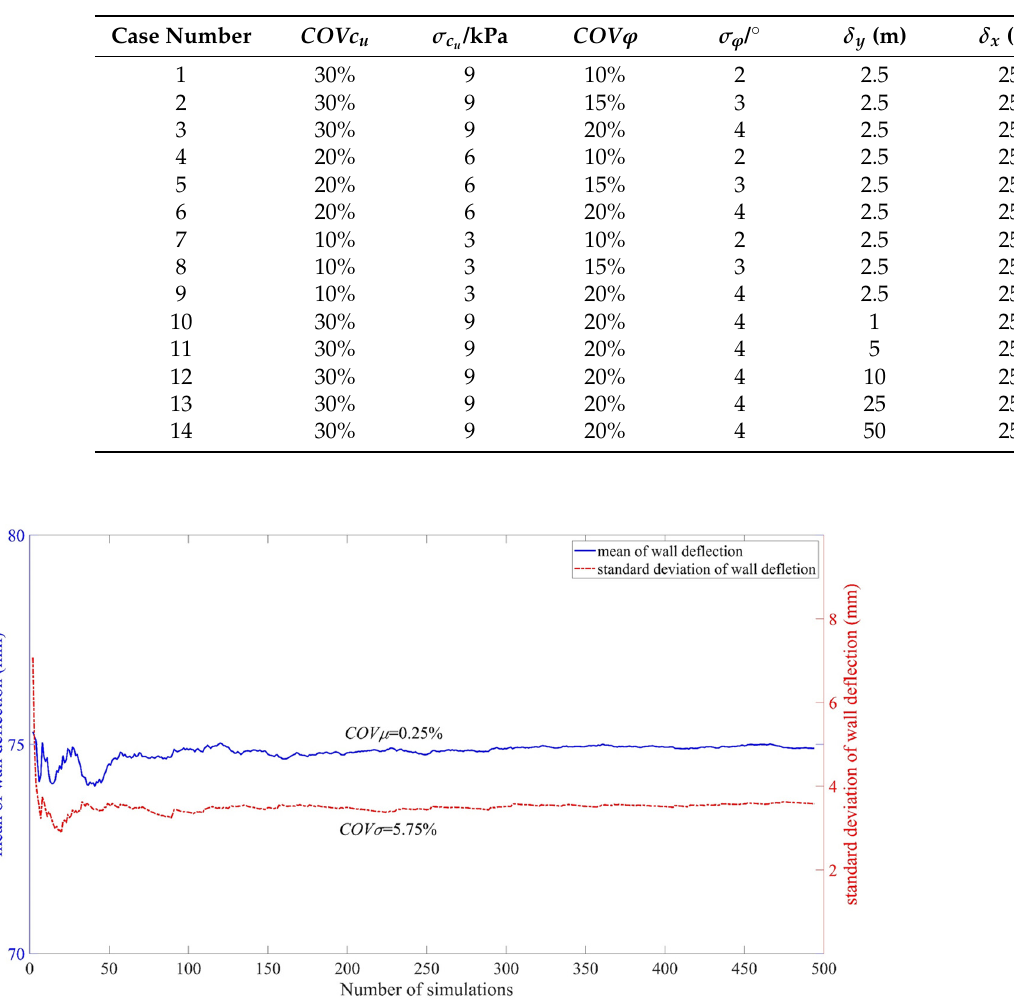
Table 3. Values of parameters in design cases.